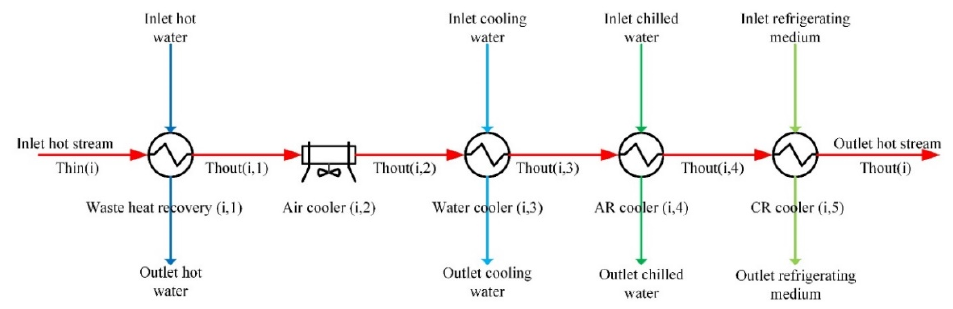
Figure 1. Structure of the cascade cooling system.